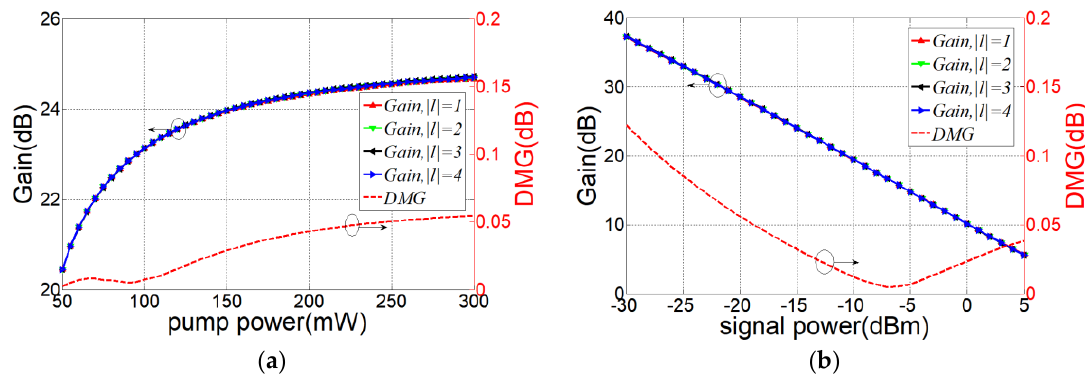
Figure 5. ( a ) Gain and DMG versus pump power; ( b ) Gain and DMG versus signal power.